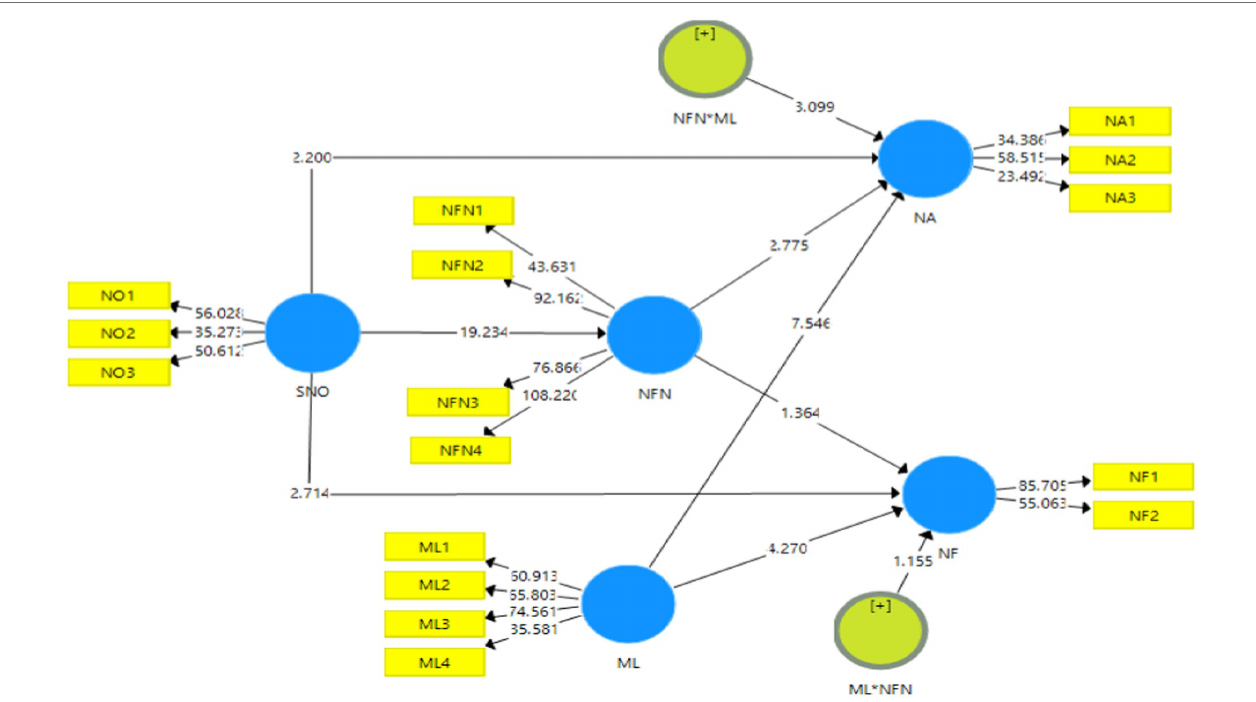
FIGURE 5 | Structural model bootstrapping with moderation. SMO, Social Media Overload; NA, News Avoidance; NF, News Filtering; NFN, Need for News; and ML, Media